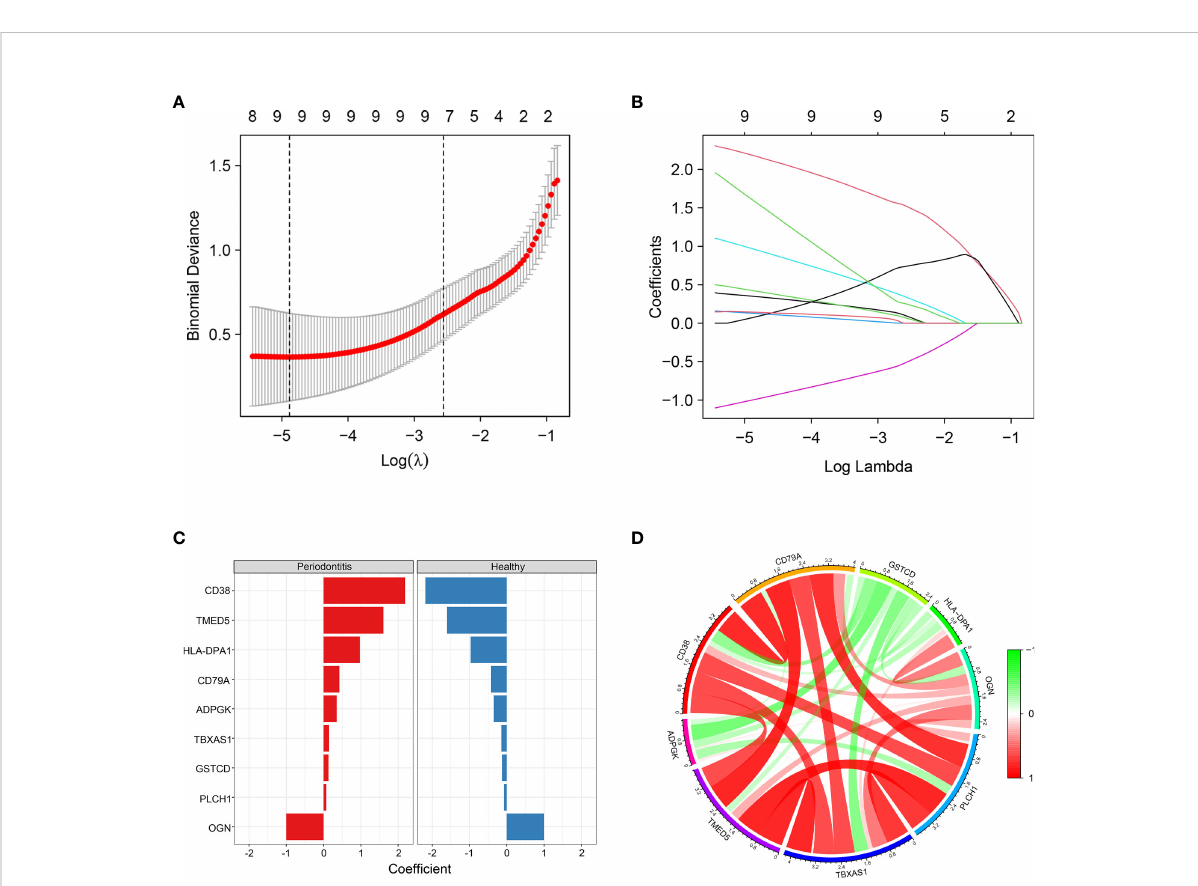
FIGURE 4 Screening of hub DEPs using LASSO regression analysis. (A) Coef fi cients of nine DEPs were selected by the lambda with the minimum binomial deviance marked by the black dashed line (ln(lambda) = -4.88). (B) The LASSO binomial model fi tting process. Each curve represents a variable. (C) Coef fi cient values for each of the nine selected proteins from LASSO regression. A positive coef fi cient for a protein signature within its class indicates that elevated expression of this protein increases the probability of a specimen belonging to its tissue type. (D) Circos plot shows the correlations between the nine hub DEPs according to the protein expression levels. Green connecting lines represent negative correlations, and red lines represent positive correlations.